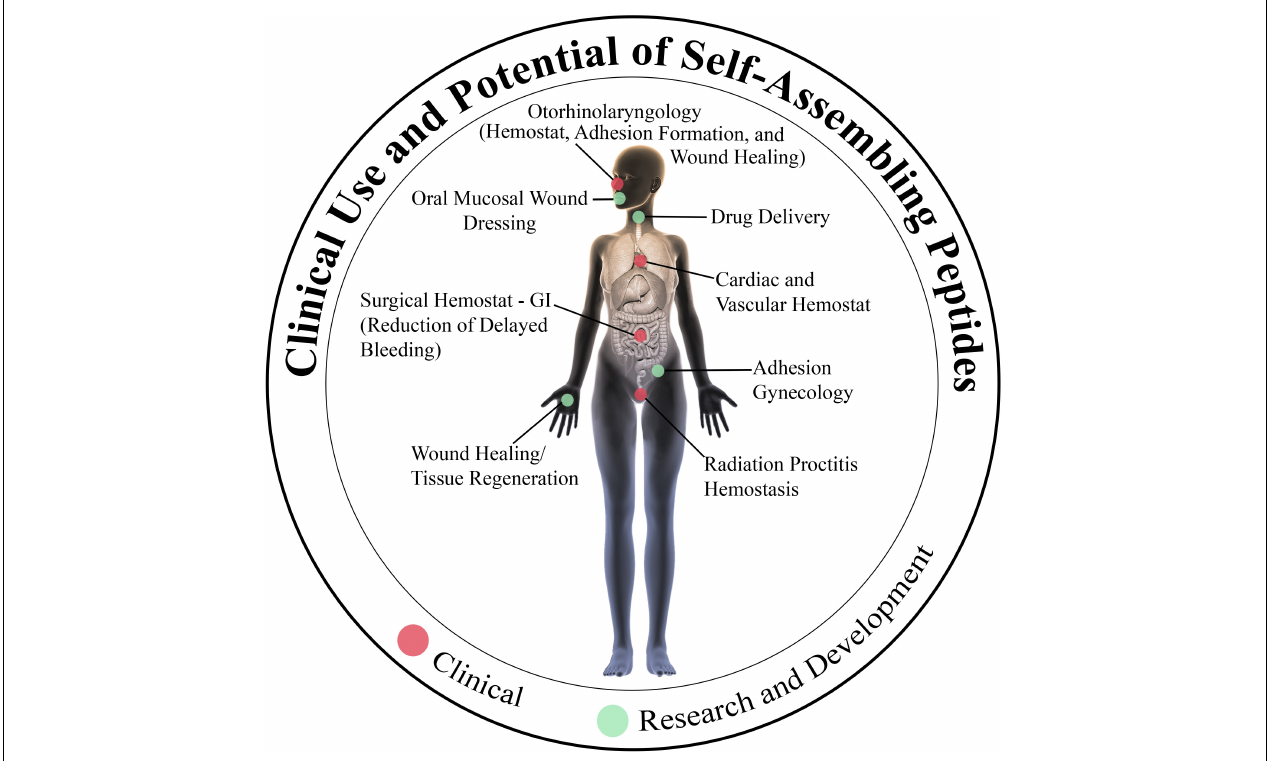
FIGURE 6 | Current and future clinical uses of the self-assembling peptide RADA16. Hemostatic RADA16 formulations are currently in use for stopping intraoperative bleeding and preventing delayed/rebleeding in cardiovascular, gastrointestinal, and otorhinolaryngological surgical procedures. Experimentation is underway to determine if RADA16 can act as a surrogate extracellular matrix to improve wound healing and tissue regeneration in diverse tissues and organs, and possibly act as a precisely regulated drug delivery